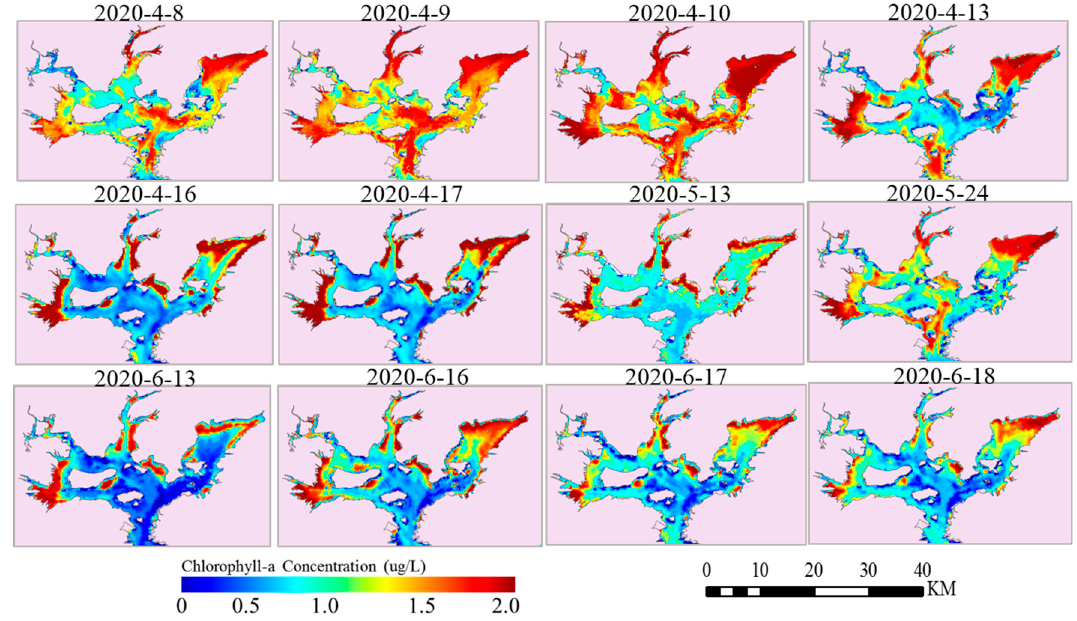
Figure 7. Spatial distribution of chl ‐ a concentration based on the LightGBM model in Sansha Bay of Fujian Province.